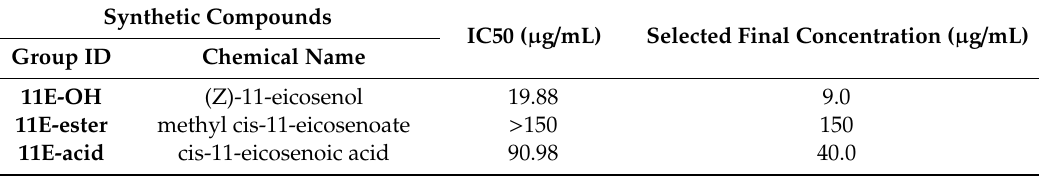
Table 1. Sample groups, IC 50 concentrations and final chosen concentrations of synthetic bee